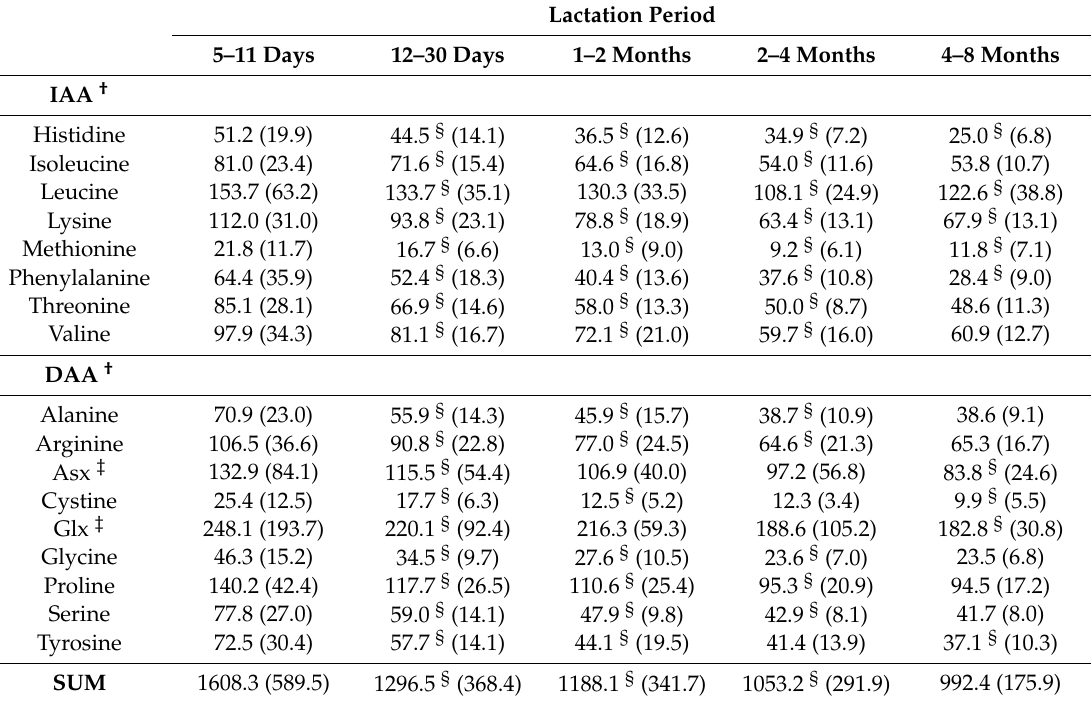
Table 2. Total amino acid content (mg/100 g) of milk from the different lactation periods.